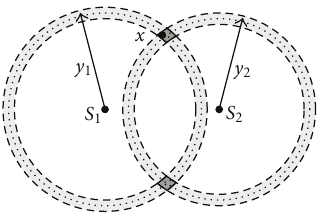
Figure 7: A range-only sensor system, with 2D-position sensors in S S 1 and 2 with indicated range resolution.